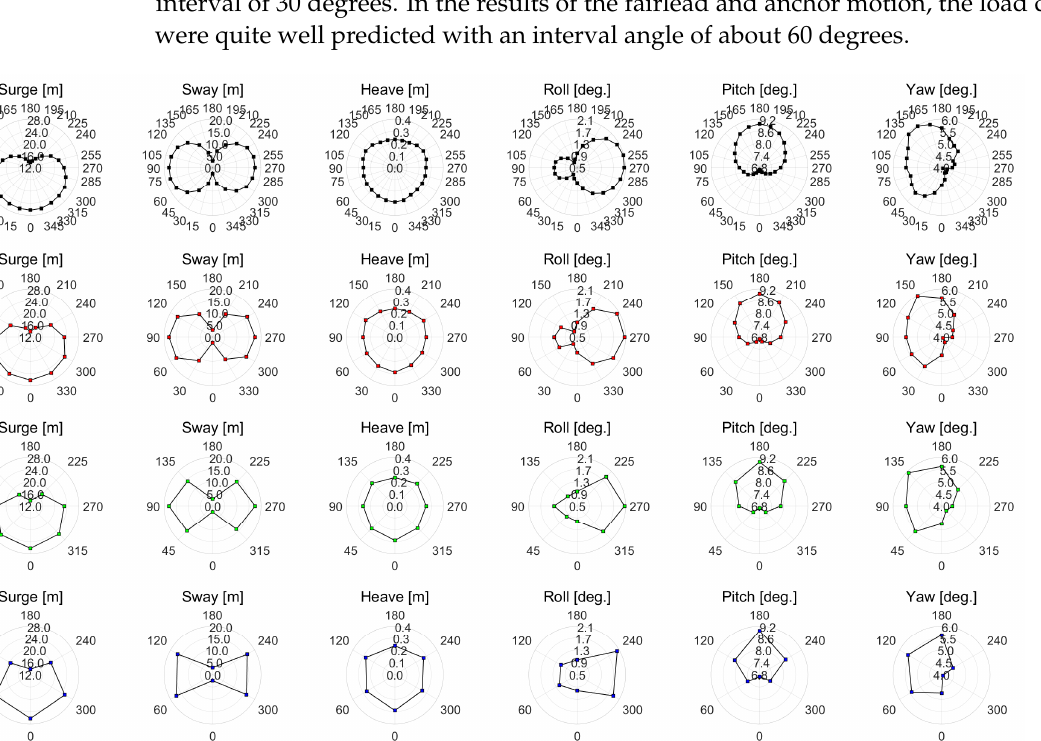
Figure 15. Maximum values of the blade and tower’s moments according to the interval angles.